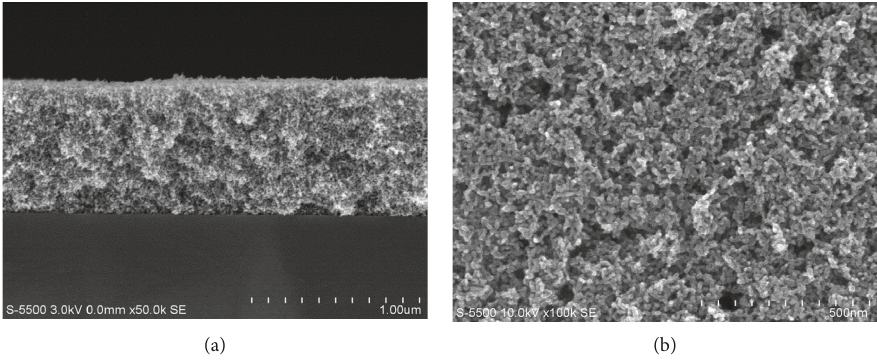
Figure 6: (a) FE-SEM cross-sectional image of a mesoporous TiO 2m layer. (b) FE-SEM image of the surface of a mesoporous TiO